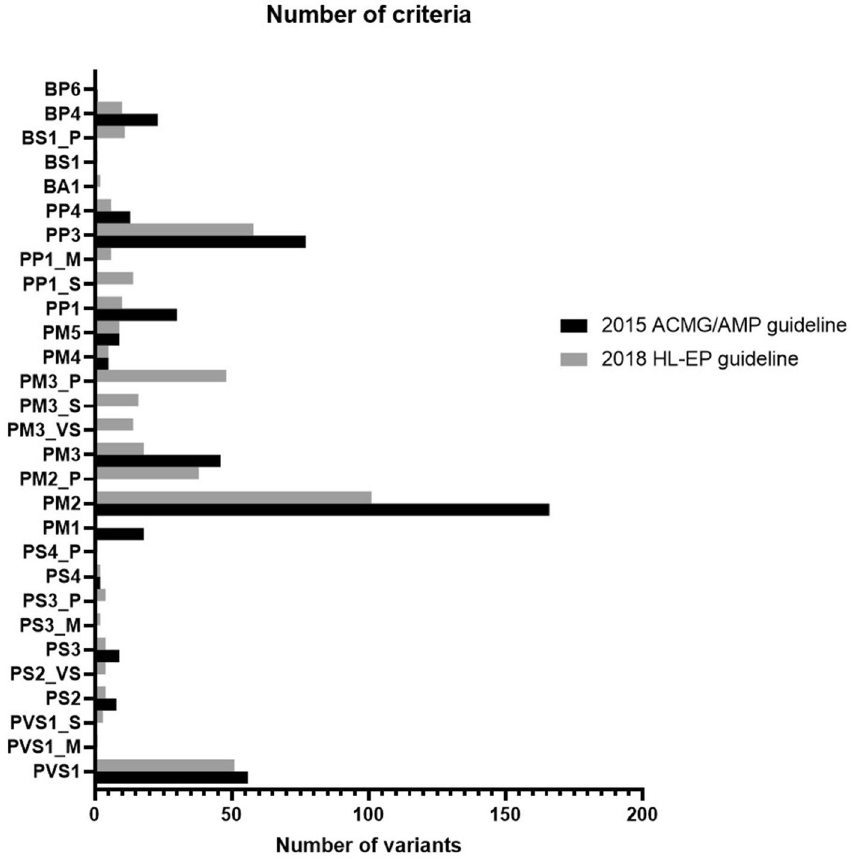
Figure 3. Frequency of criteria applied in the 2015 ACMG/AMP and 2018 HL-EP guidelines. The most commonly applied rule in the two guidelines was PM2 and the criterion of PM3 yielded the most drastic difference between the 2015 ACMG/AMP and 2018 HL-EP